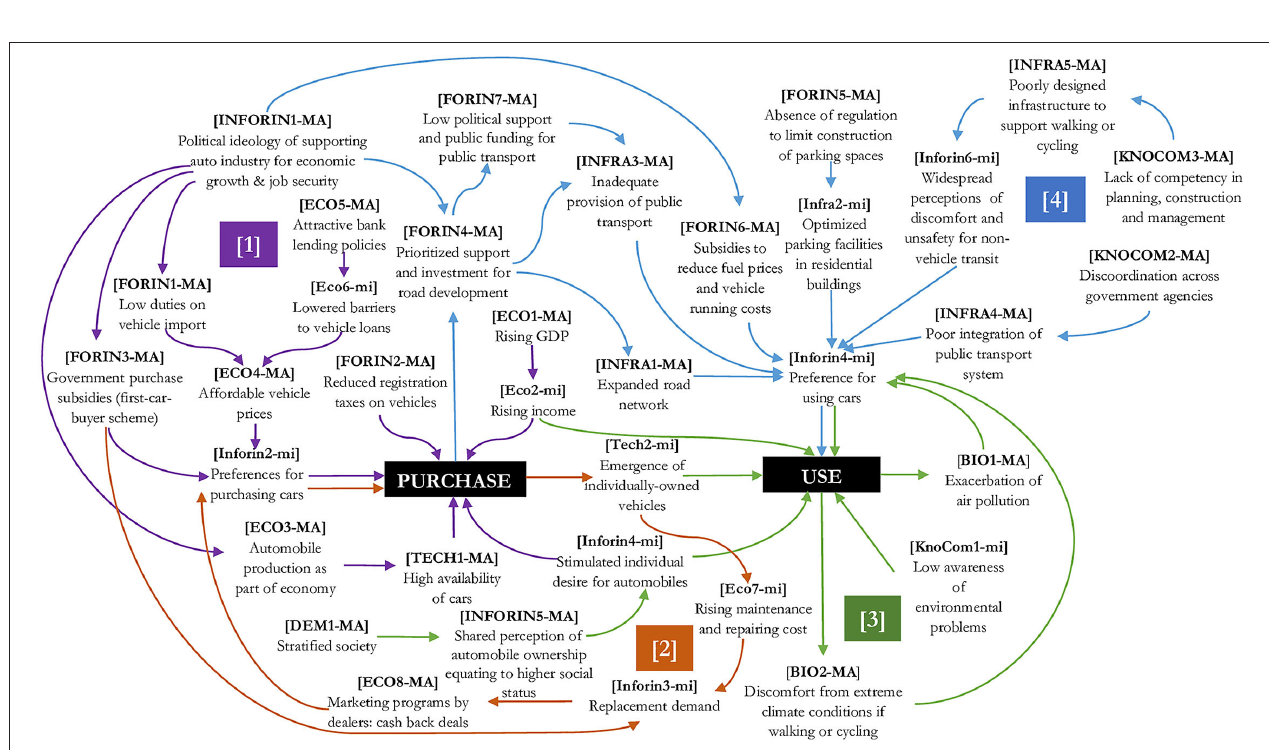
FIGURE 3 | Visualization of mechanisms contributing to the lock-in of mobility based on individual passenger vehicles in Bangkok (Source: Authors).